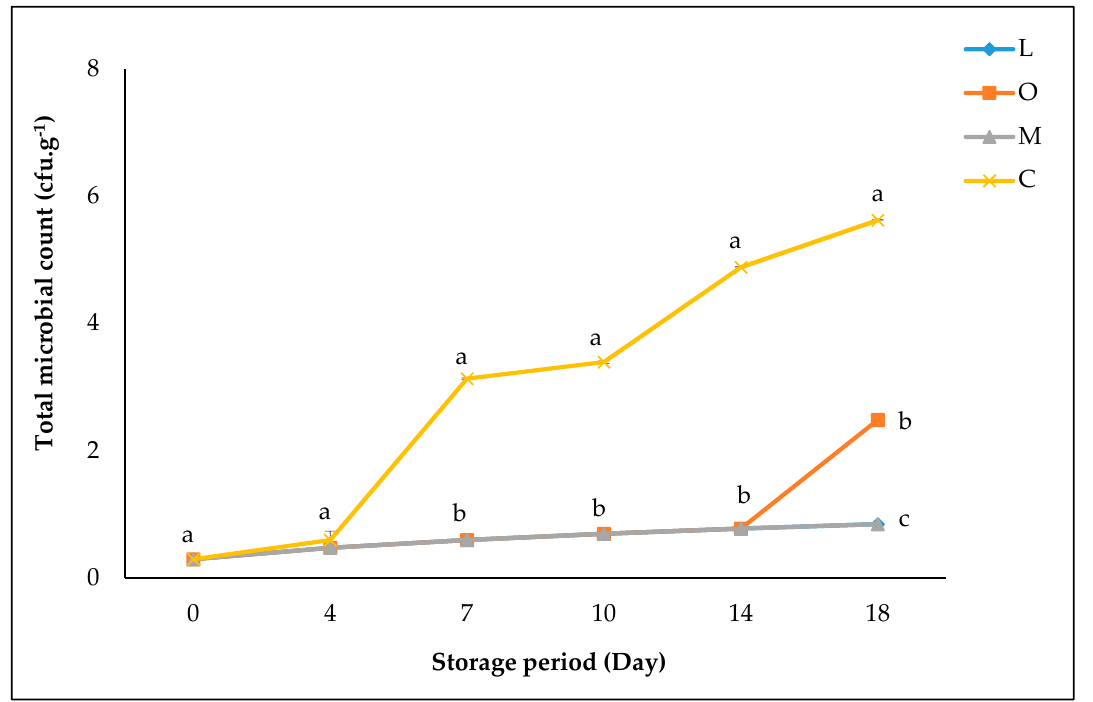
Figure 15. Effect of different essential oil emulsions (L = lemon, O = orange, and M = mandarin Figure 15. E ff ect of di ff erent essential oil emulsions (L = lemon, O = orange, and M = mandarin essential oil) on total microbial content of strawberry fruits stored at 2 °C for 18 days. Vertical bars essential oil) on total microbial content of strawberry fruits stored at 2 ◦ C for 18 days. Vertical bars indicate the standard deviation (n = 6). Means and di ff erent letters indicate significant di ff erence between treated and control fruits at each storage period (Duncan’s of